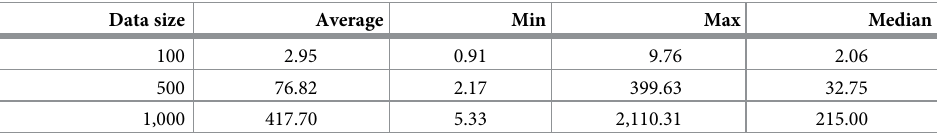
Table 1. Number of data and inference time (in